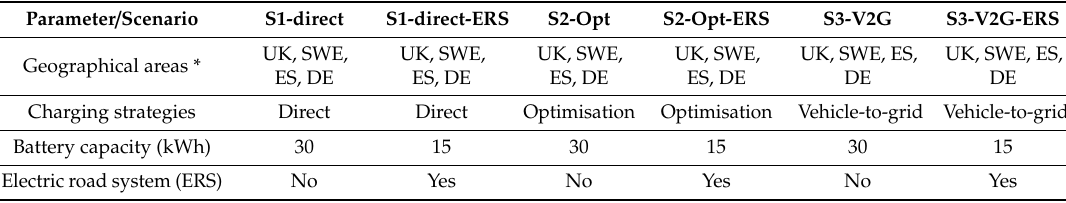
Table 2. The six scenarios modelled in this